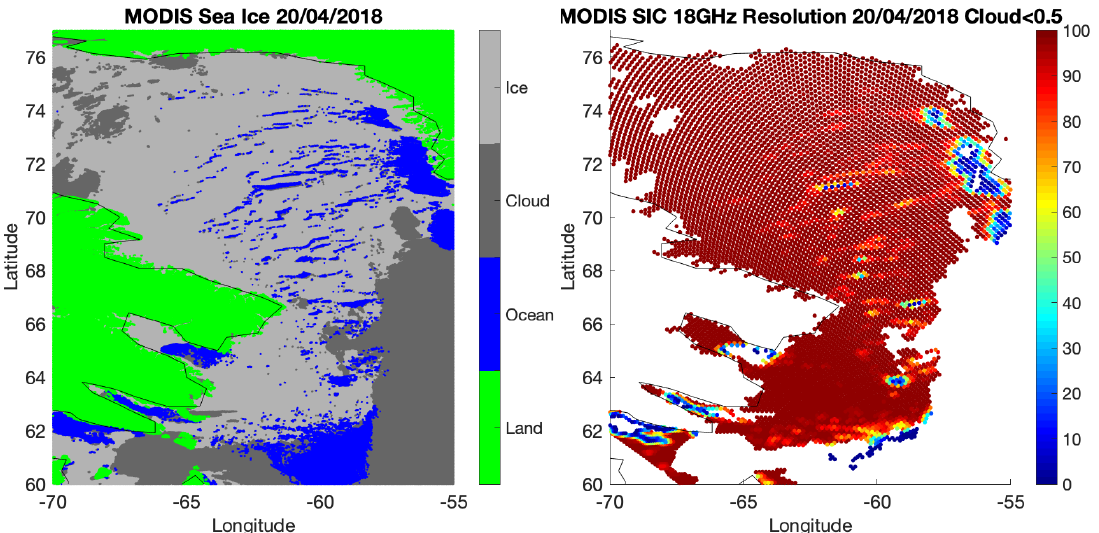
Figure 1. The Moderate Resolution Imaging Spectroradiometer (MODIS) sea ice information for the selected scene, 20 April 2018. Left: the original MODIS sea ice data at 1 km spatial resolution. Right: the MODIS-derived Sea Ice Concentration (SIC), as calculated from spatial averaging over the 18 GHz AMSR2 footprint, when the cloud cover is less than 50%. The landmasses are Greenland in the north-east of the image and Baffin Island in the